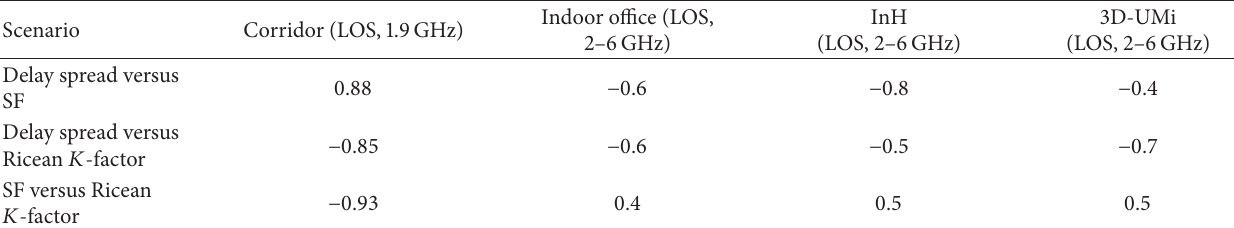
Table 7: Cross correlation coefficients in another frequency